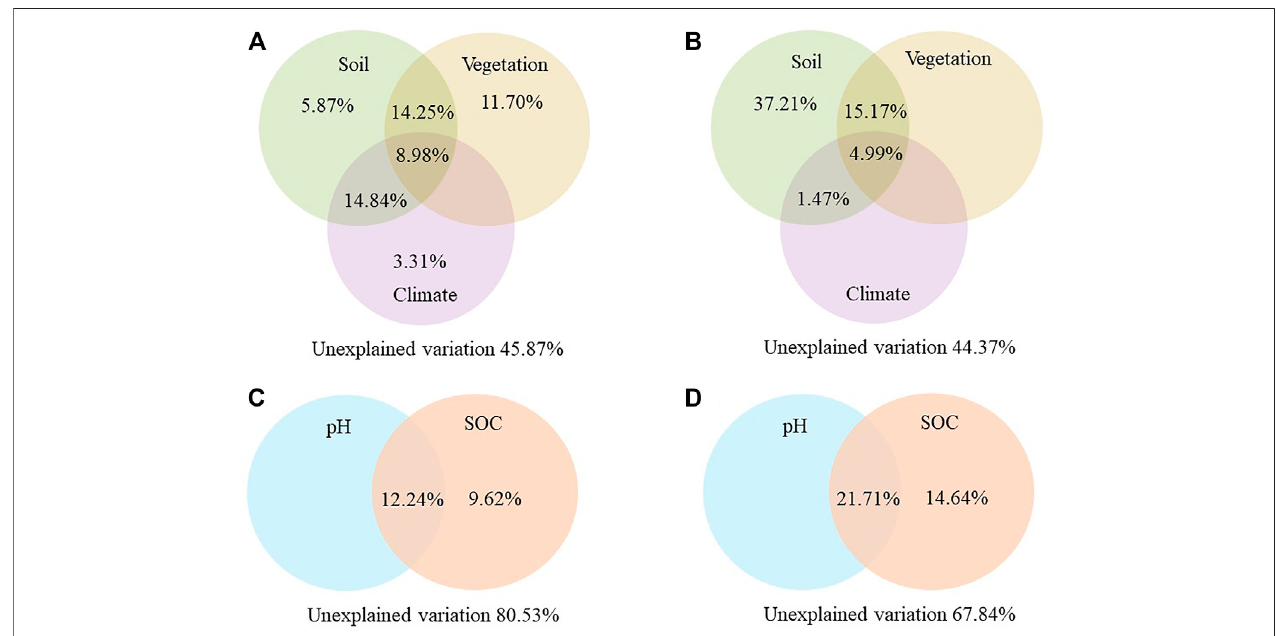
FIGURE 4 | The results of variation partitioning analysis for soil total nitrogen density (A,B) and soil total phosphorus (C,D) in alpine wetlands (A,C) and alpine meadow (B,D) . For soil total nitrogen density, variation partitioning analysis consisted of explained variation, including soil properties refer to soil pH, soil organic carbon density, climate factor refers to mean annual precipitation, and vegetation includes belowground biomass in alpine wetlands and aboveground biomass in alpine meadow, their joints effects, and unexplained variation. In addition, for soil total phosphorus, the variation partitioning analysisconsisted of SOC and pH. SOC, soil organic carbon density; pH, soil